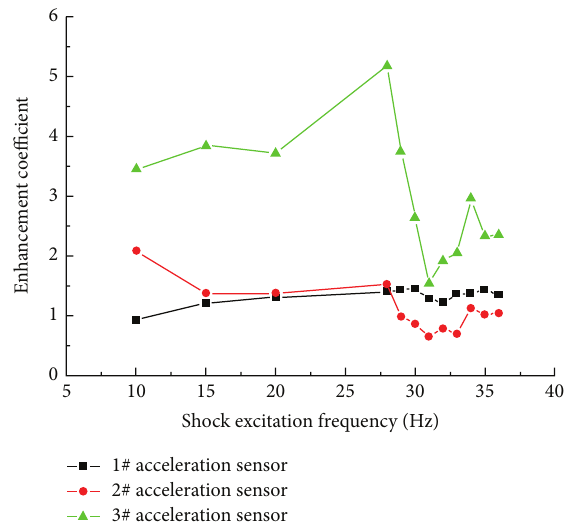
Figure 20: Enhancement coefficient curve of the acceleration response (1.5g).